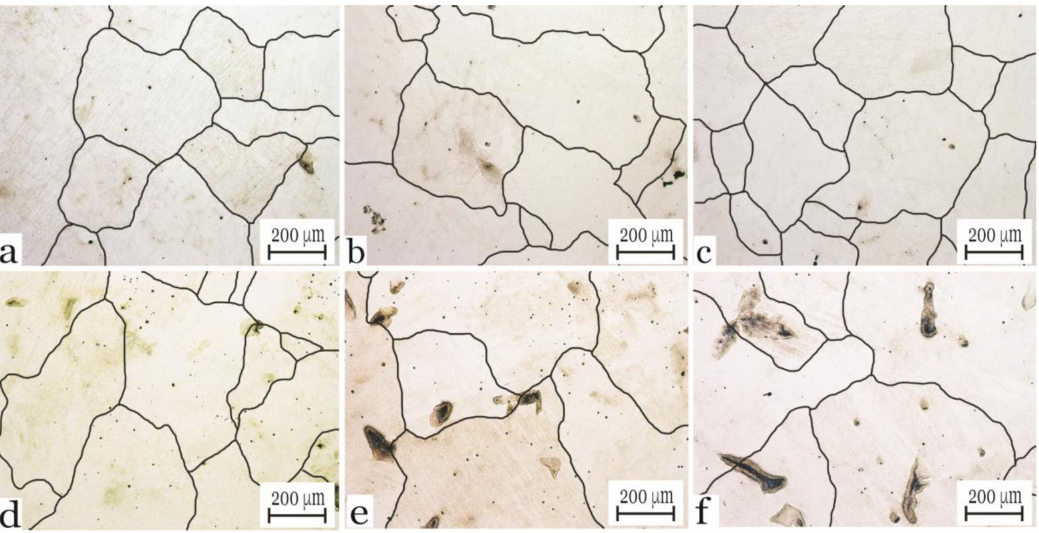
Figure 6. Prior austenite grains after soaking treatments. ( a , d ) DQ steel, ( b , e ) DQ + 0.02Nb, ( c , f ) DQ + 0.05Nb. Upper row 1050 ◦ C, lower row 1200 ◦ C. Grain boundaries